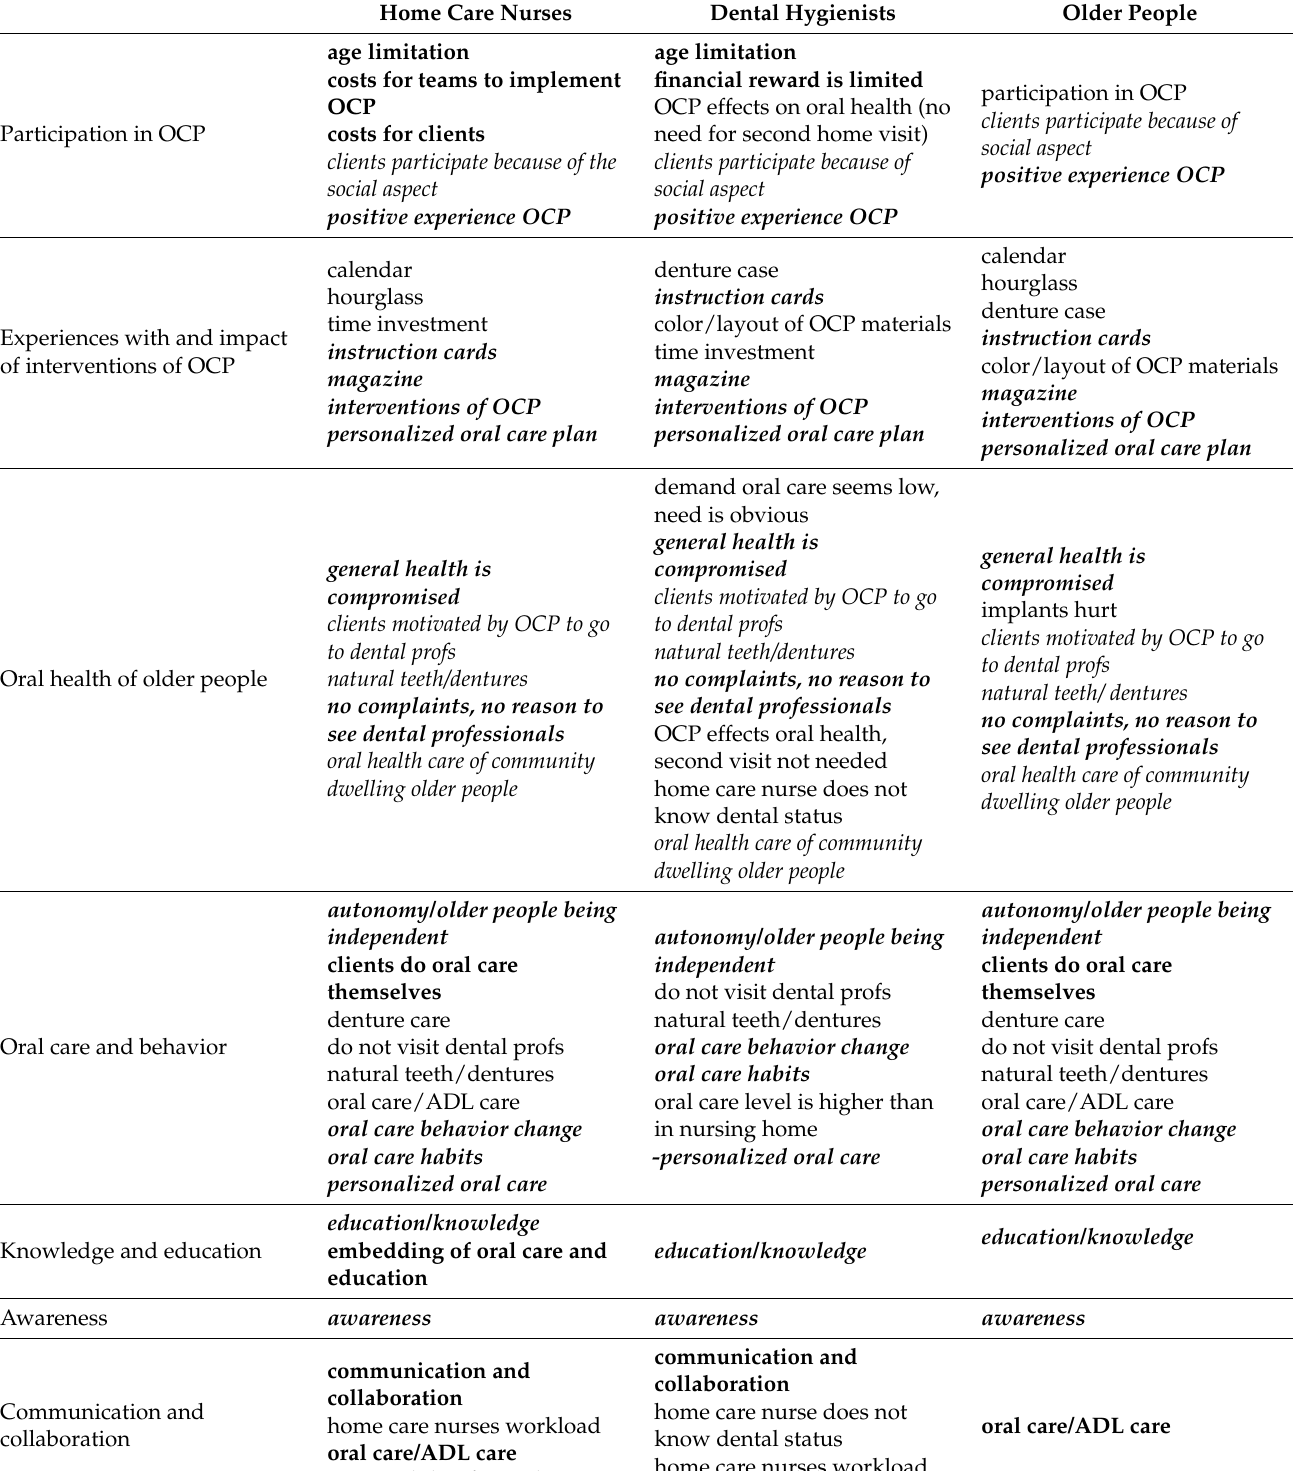
Table 1. Overview of codes and themes, structured by stakeholder